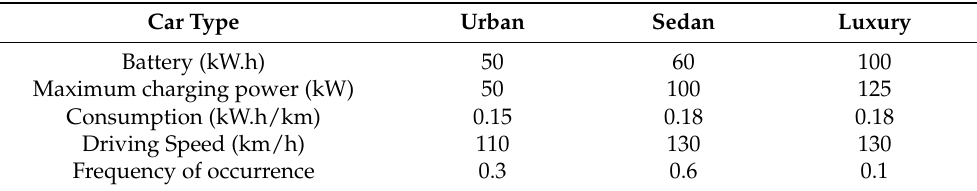
Figure 7. Highway characteristics. Table 1. Studied vehicles. Table 1. Studied vehicles.